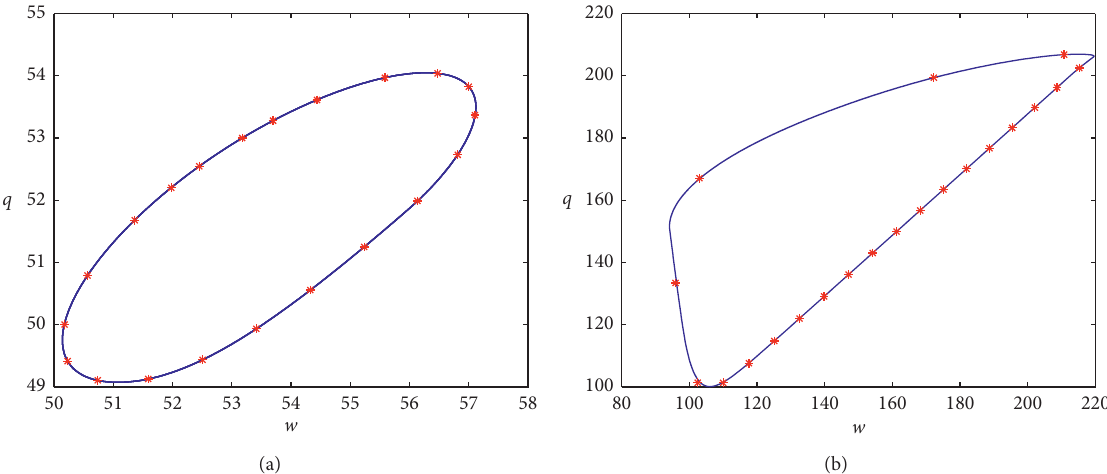
Figure 6: The phase portraits are displayed in (a) and (b), where solid blue lines represent numerical results and red ∗ are the results of the HB-AFT